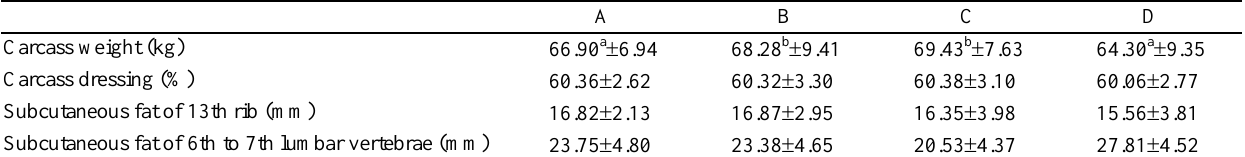
Table 3. Effect of dietary carob pods on pig carcass weight, carcass dressing percentage, and subcutaneous fat of the 13th rib and the 6th to 7th lumbar vertebrae (Mean  SD)